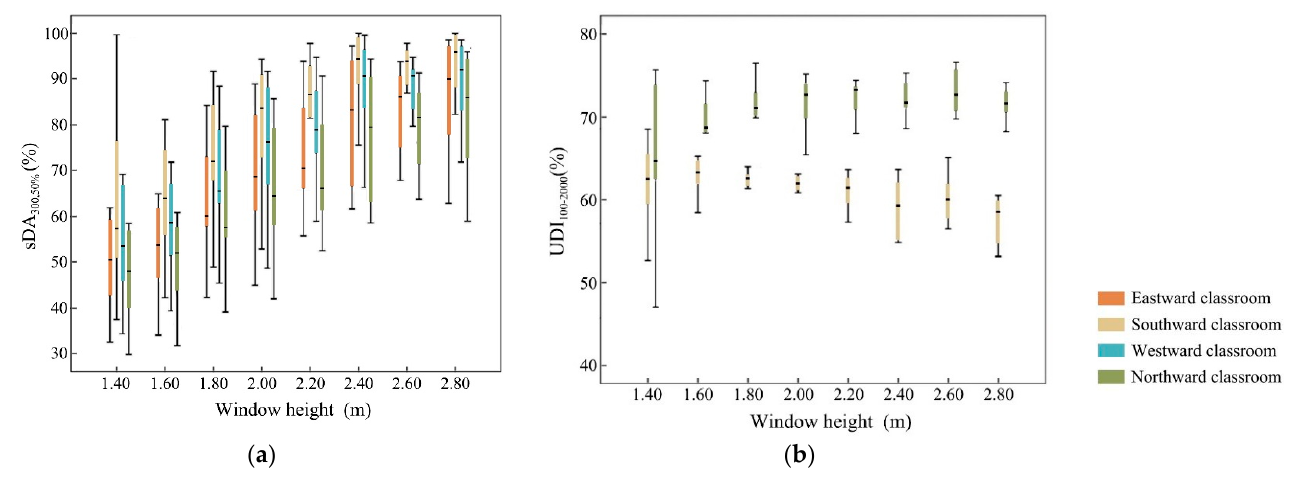
Figure 9. The analysis results of the distribution interval between the window height and the evaluation indices: ( a ) the analysis results of sDA 300,50% ; ( b ) the analysis results of UDI 100–2000 .